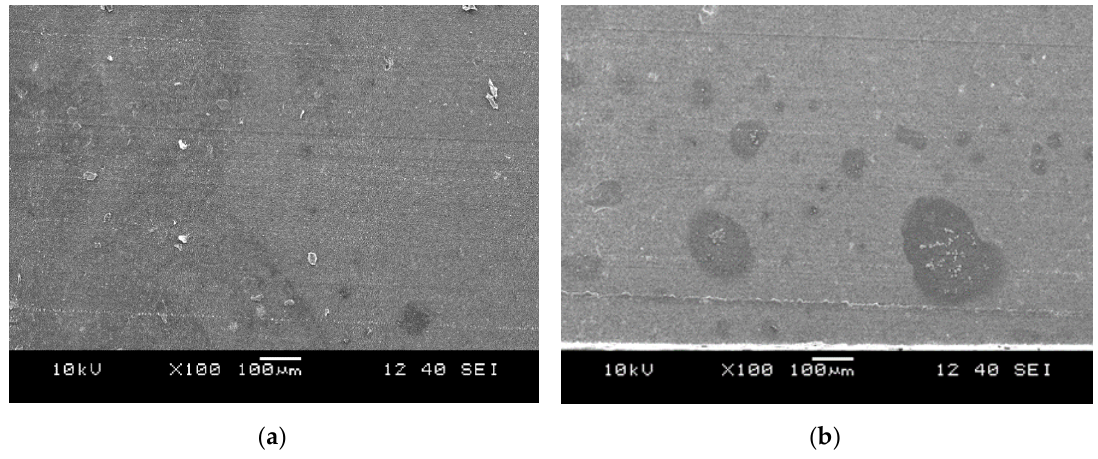
Figure 9. Cryomicrotomed surfaces of the TDVs produced with different screw configurations: ( a ) Screw configuration “A” (A_S_L_1_50 MR); ( b ) Screw configuration “B” (B_S_L_1_50 MR).